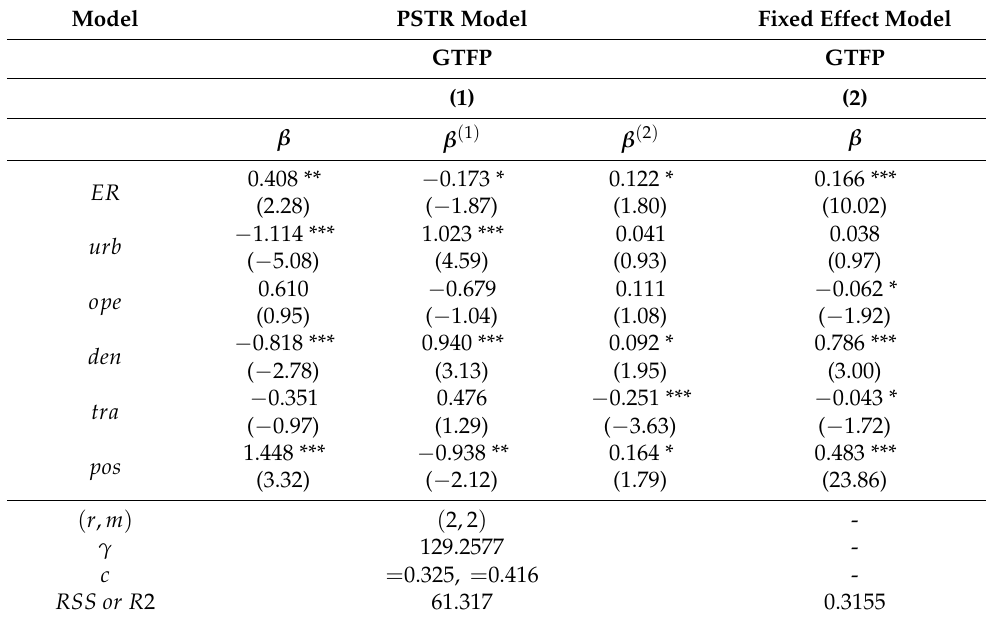
Table 5. Empirical results of ER based on the PSTR model.